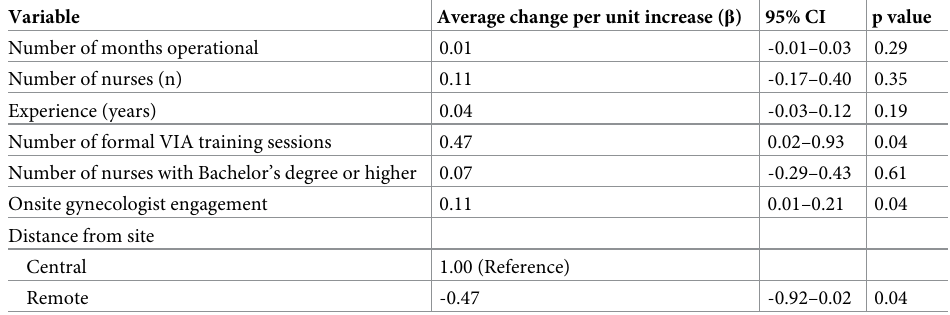
Table 4. Site characteristics as predictors of weighted kappa estimates from univariate linear regression models.